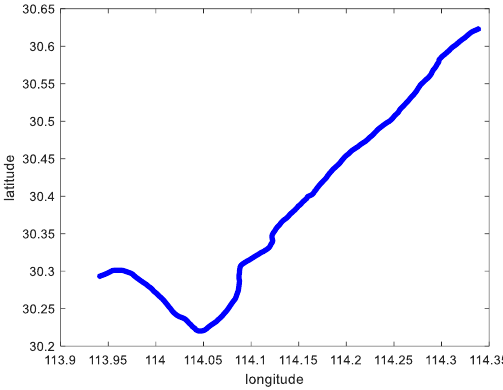
Figure 10. The original trajectory of scenario 1.